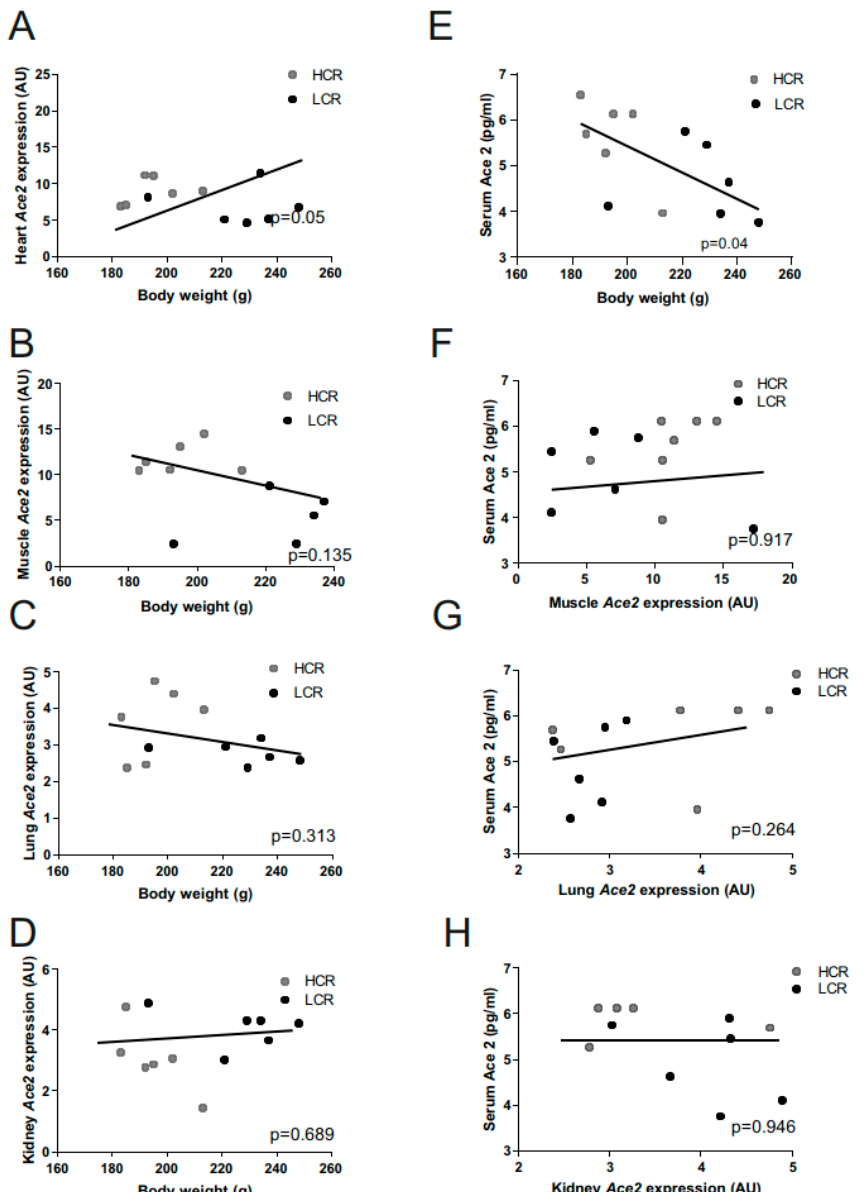
Figure 3. Correlation between body weight and ACE2 expression and ACE2 serum concentration.